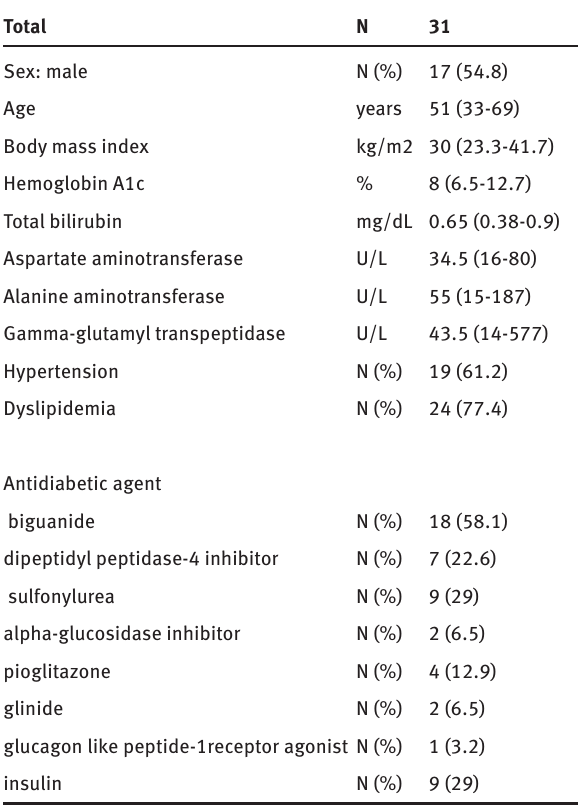
Table 2: Baseline characteristics of 31 patients with non-alcoholic fatty liver disease: